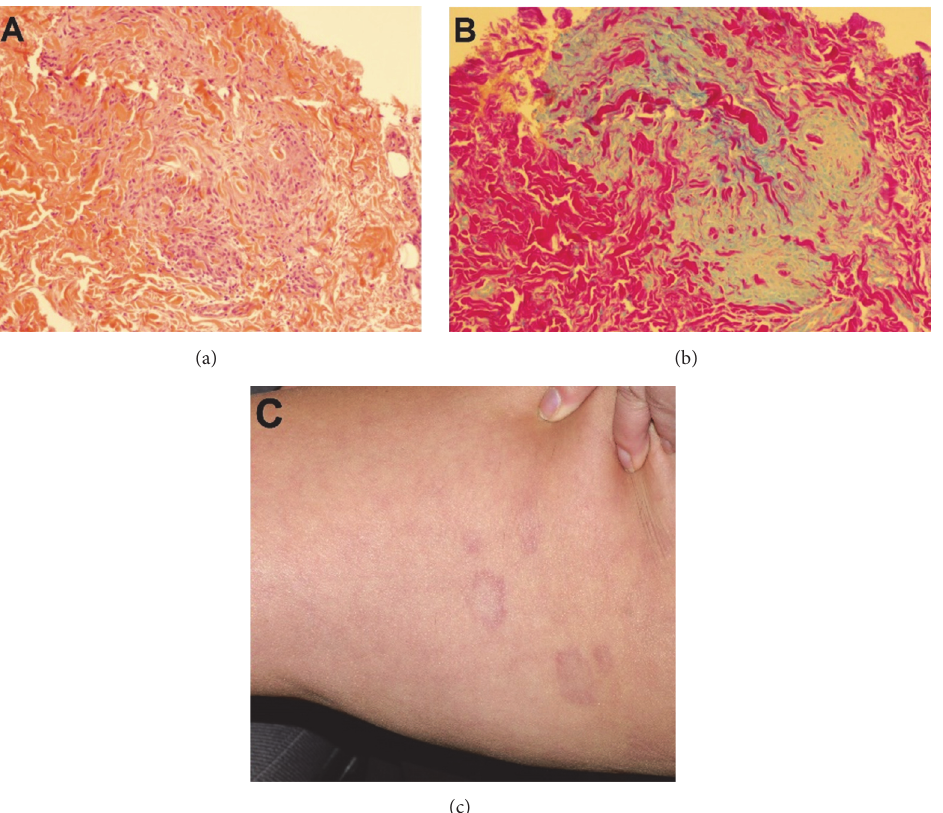
Figure 1: Granuloma annulare. (a) A palisading granuloma with central collagen degeneration (H&E stain, magnification × 100); (b) Alcian blue stain showing increased mucin deposition within the granuloma (Alcian blue stain, magnification × 100); (c) several annular red-brown plaques involving the